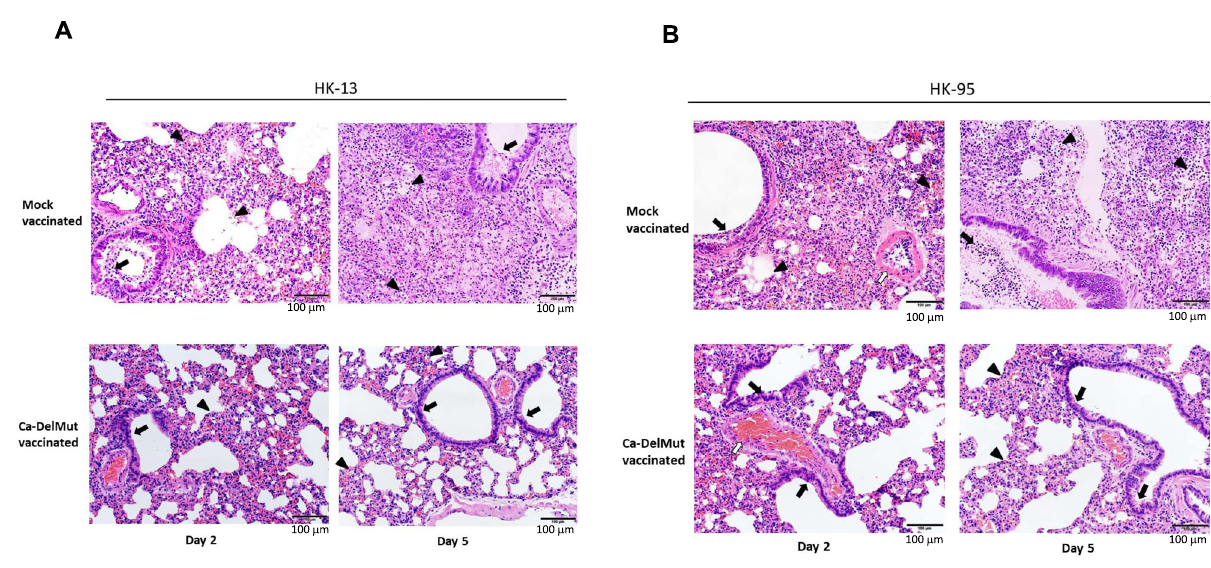
Fig. 7 Histopathological analysis of lung pathology in WT-virus-challenged Ca-DelMut- and mock-immunized hamsters. At day 28 after immunization, hamsters were challenged with 1 × 10 3 pfu of either HK-13 or HK-95 virus. At days 2 and 5 post-infection, lungs were collected, fi xed, processed into paraf fi n blocks, and sections H&E stained. A Challenge with HK-13. Day 2: Mock-vaccinated hamster lungs showed bronchiolar epithelial cell death and the bronchiolar lumen fi lled with exudate and cell debris (arrow). Diffuse alveolar in fi ltration and focal hemorrhage were also seen (arrowheads). Ca-DelMut- vaccinated hamster lungs showed regional alveolar septal in fi ltration and blood vessel congestion (arrowhead), but no obvious bronchiolar epithelial cell death (arrow). Day 5: Lungs of mock-vaccinated hamsters showed severe alveolar in fi ltration and exudation (arrowheads), as well as bronchiolar luminal exudation (arrow). Vaccinated hamster lungs showed focal alveolar septal in fi ltration (arrowheads), while the bronchiolar epithelium appeared normal with no luminal secretion or cell debris (arrows). Images were representatives of three independent experiments. B Challenge with HK-95. Day 2: Mock- vaccinated hamster lungs showed bronchiolar epithelial cell death with luminal cell debris (arrow) and diffuse alveolar in fi ltration with focal hemorrhage and exudation (arrowheads), with a medium sized blood vessel showing severe endotheliitis (open arrow). Vaccinated hamster lungs showed regional alveolar septal in fi ltration and blood vessel congestion; a blood vessel appeared to be normal (open arrow), and no obvious bronchiolar epithelial cell death was observed (arrows). Day 5: Lungs of mock-vaccinated control hamsters showed severe alveolar in fi ltration and exudation (arrowheads) and bronchiolar luminal cell debris (arrow). Vaccinated hamster lungs showed focal alveolar septal in fi ltration (arrowheads), while the bronchiolar epithelium appeared normal without luminal secretion (arrows). Scale bar: 100 µ m. Images were representatives of three independent